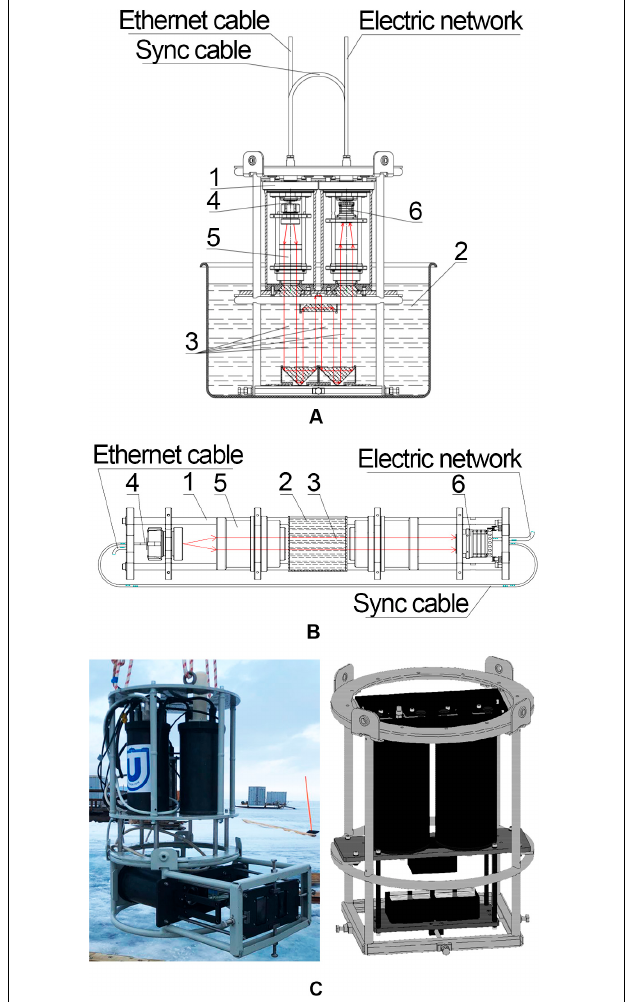
FIGURE 1 | (A) Digital hologram recording scheme using submersible digital holographic camera (DHC) (folded configuration) in laboratory conditions. (B) Digital hologram recording scheme using DHC (laboratory linear configuration) in laboratory conditions. 1 – DHC, 2 – laboratory water tank (A) or cuvette (B) with plankton, 3 – studied (recorded) volume, 4 – laser, 5 – beam expander, 6 – CMOS camera. (C) DHC horizontal layout as part of a hydrobiological probe in the study of vertical plankton distributions of Lake Baikal in February 2019 and DHC vertical layout for the study of plankton temporal